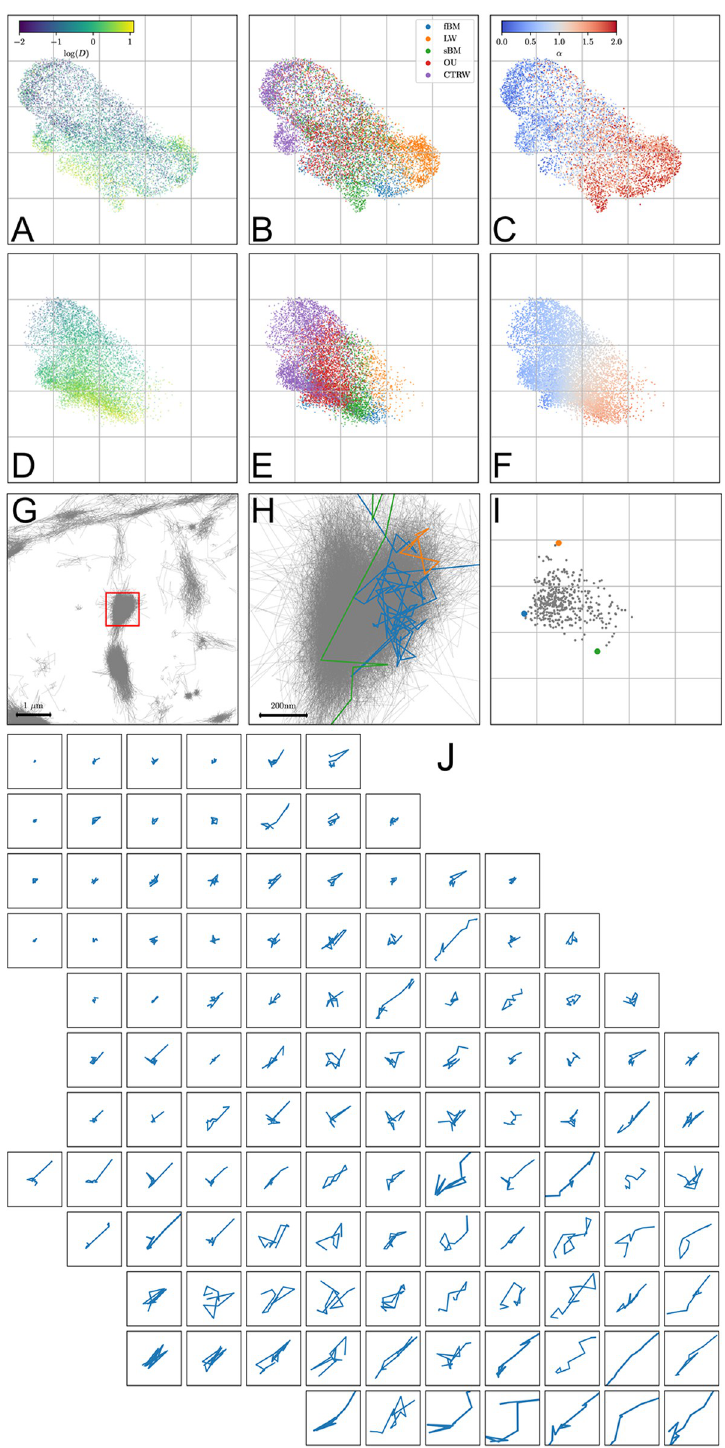
Fig 3. 2D Latent space of trajectories. ( A, B, C ) Latent representations of simulated trajectories, colored according to the true log-diffusivity, the true random walk model (fBM: fractional Brownian motion; LW: Levy walk; sBM: scaled Brownian motion; OU: Ornstein-Uhlenbeck process; CTRW: continuous-time random walk) and the true anomalous diffusion exponent. ( D, E, F ) Latent representations of recorded trajectories, colored according to the same variables as above, this time using inferred values. ( G ) Recorded trajectories at synapses and in the axon. ( G ) Zoom on a presynaptic bouton, delimited by the red square in panel D. Three individual trajectories are highlighted. ( I )